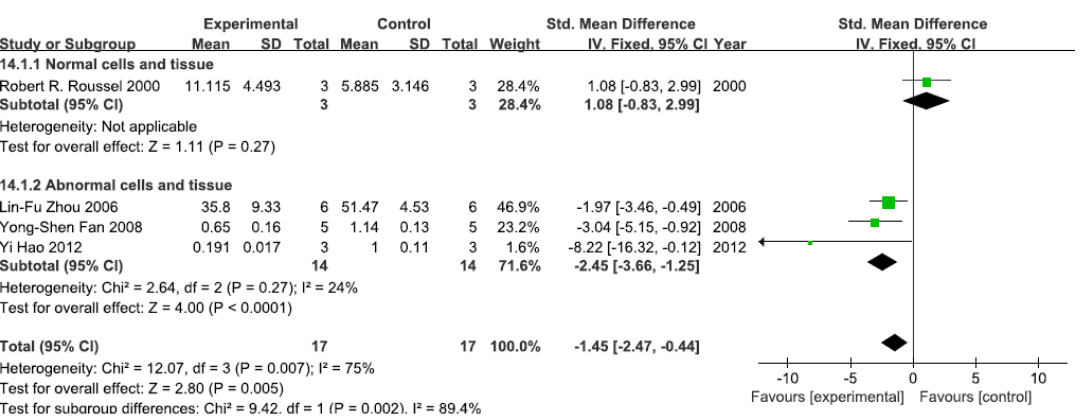
Figure 7. Effects of arsenic on nuclear transcription factor kappa B activity(NF ‐κ B activity). Forest plot showing the impact of arsenic treatment on NF ‐κ B activity compared with controls. Abbreviations: SMD = standardized mean difference, IV = independent variable, 95% CI = 95% confidence interval.